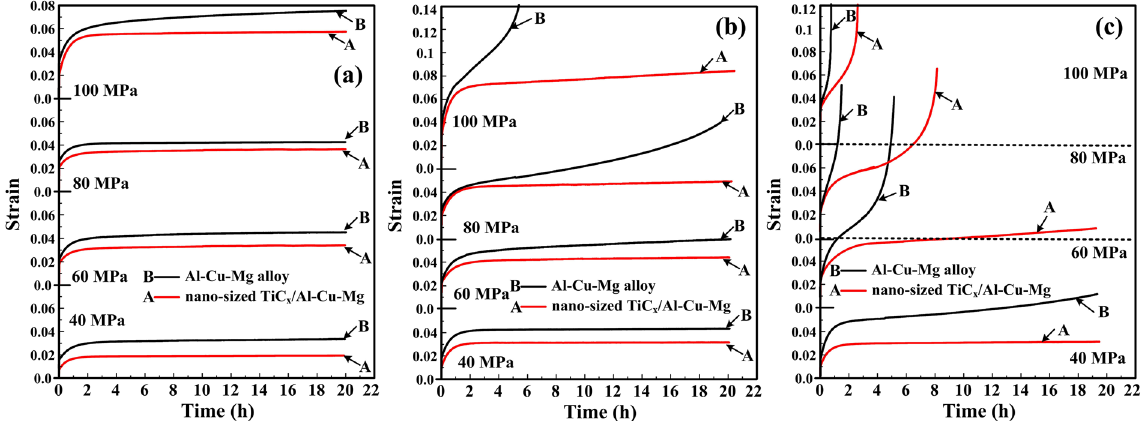
Figure 3. Creep curves of Al-Cu-Mg alloy and nano-sized TiC x /Al-Cu-Mg composite obtained with applied stress of 40 MPa, 60 MPa, 80 MPa and 100 MPa at ( a ) 493 K, ( b ) 533 K and ( c ) 573 K.